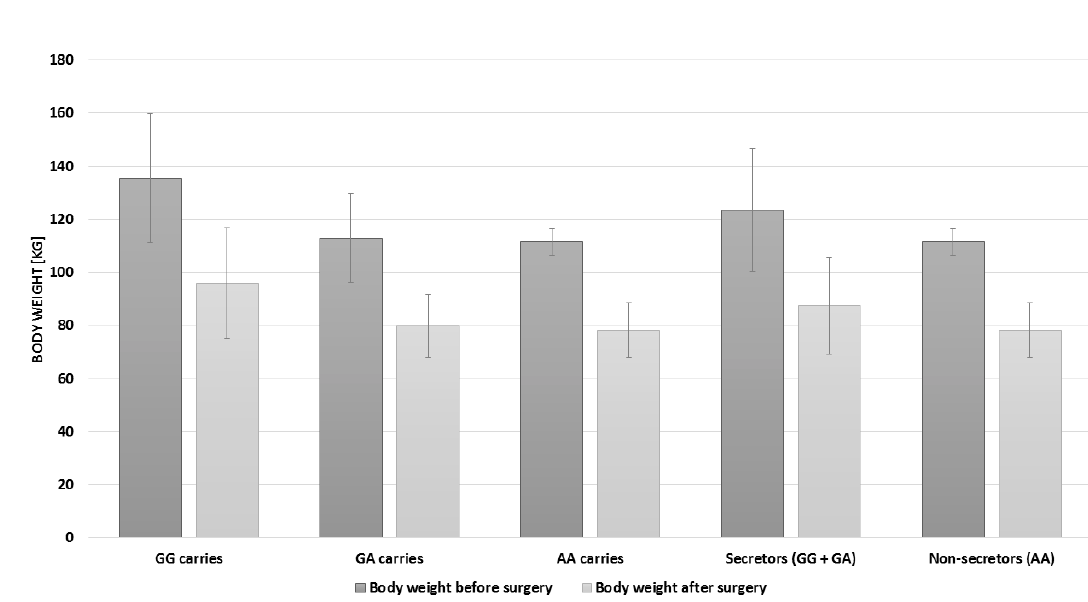
Figure 2. Body weight of FUT2 variants.